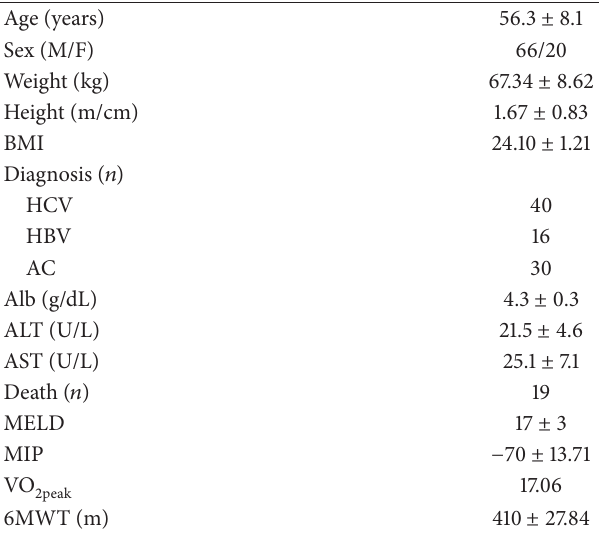
Table 1: The patients’ anthropometric and clinical characteristics.